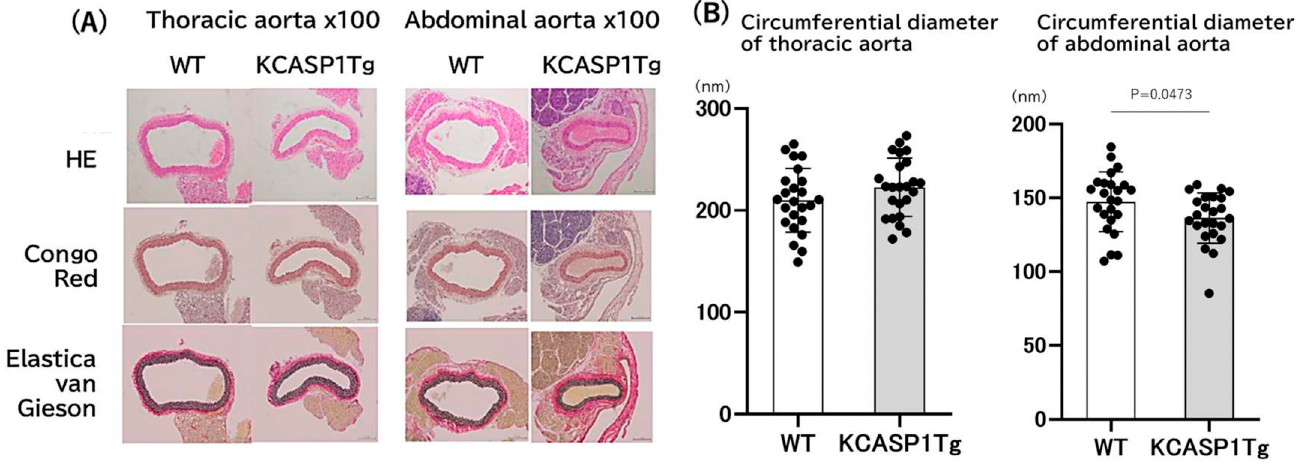
Figure 1. Histological analysis of thoracic and abdominal aorta. The narrowing of the artery was observed in KCASP1Tg mice especially at the abdominal aorta compared to WT mice. Representative pictures of H&E, Congo-Red, and Elastica van Ginson staining were shown ( A ). There were no pathological abnormalities at the thoracic aorta in KCASP1Tg mice. Measurement of the artery’s lumen circumference showed a predominant decrease in the abdominal aorta of KCASP1Tg compared to WT mice. n = 24, each group. Two group comparison was analyzed with the Mann-Whitney test ( B ).